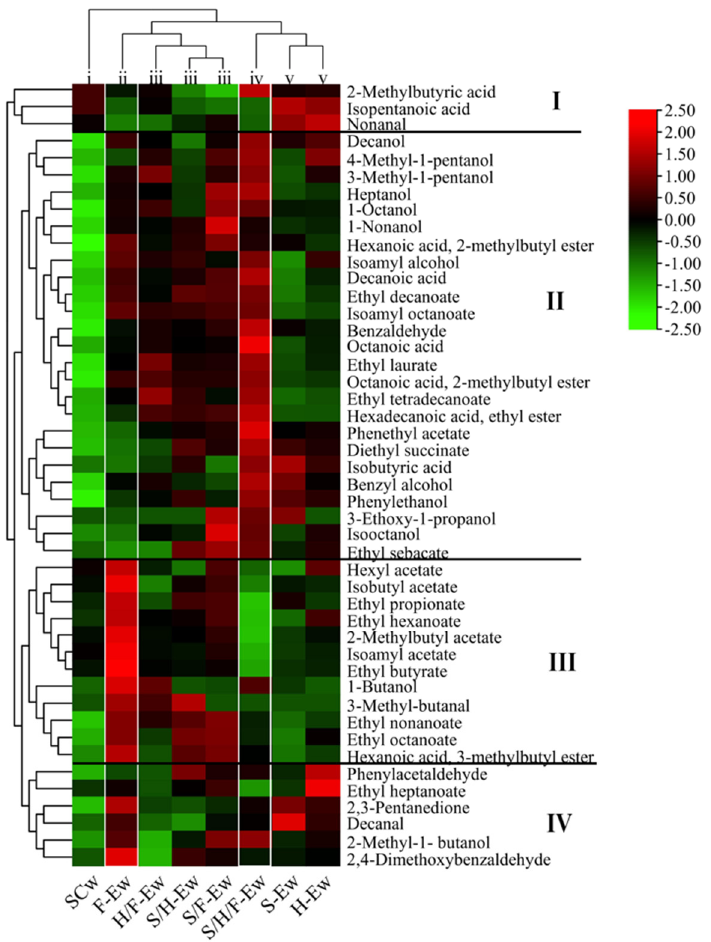
Figure 3. Fermentative aroma compound content in wines. ( A ) Benzene derivatives; ( B ) higher alcohols; ( C ) esters; ( D ) fatty acids; ( E ) carbonyl compounds. Different letters on the histogram showed significant difference ( p < 0.05).